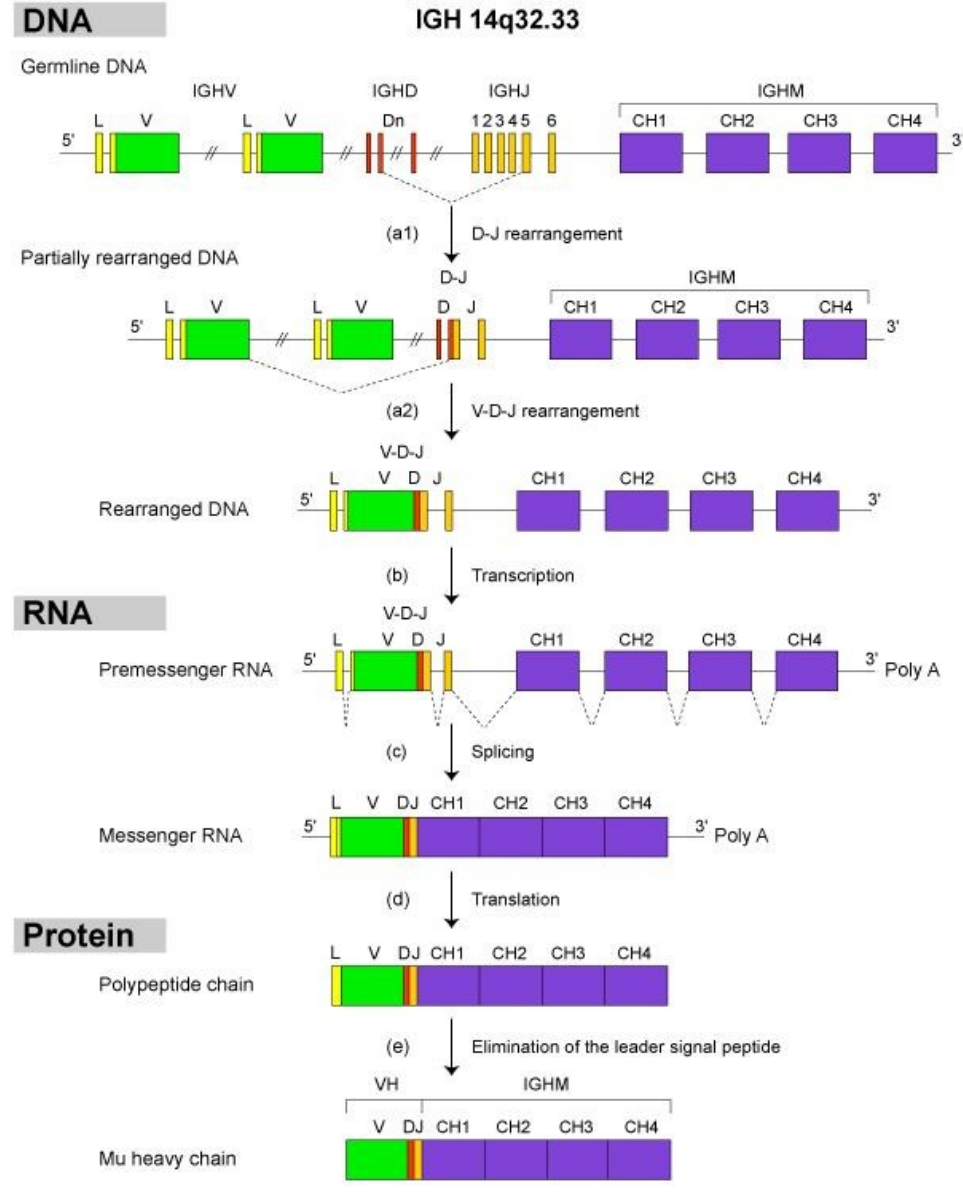
Figure 7. Synthesis of an IG H ‐ mu chain [2]. ( a1 ) At the DNA level, in a first step, one of the IGHD genes is joined to one of the IGHJ genes, with deletion of the intermediary DNA, to create a partially rearranged D ‐ J gene. ( a2 ) In a second step, one of the IGHV genes is joined to D ‐ J, with deletion of the intermediary DNA, to generate a completely rearranged IGHV ‐ D ‐ J gene. ( b ) The rearranged IGHV ‐ D ‐ J gene is transcribed with the IGHM gene into a IGHV ‐ D ‐ J ‐ M (or IGHV ‐ D ‐ J ‐ Cmu) pre ‐ messenger RNA. ( c ) The RNA sequences corresponding to the introns and to the non ‐ used IGHJ genes are excised by splicing, and a mature messenger which comprises the spliced coding regions and the 5 ′ and 3 ′ untranslated sequences, is obtained. ( d ) The messenger RNA is translated into a polypeptide chain by the ribosomes. ( e ) The signal peptide is cleaved off by a peptidase following the entry of the polypeptide chain in the endoplasmic reticulum, and a mature H ‐ mu chain is produced. In DNA and pre ‐ messenger RNA, L for Leader corresponds L ‐ PART1 and L ‐ PART2, and in spliced messenger RNA to L ‐ REGION [2]. (With permission from M ‐ P. Lefranc and G. Lefranc, LIGM, Founders and Authors of IMGT ® , the international ImMunoGeneTics information system ® , http://www.imgt.org).